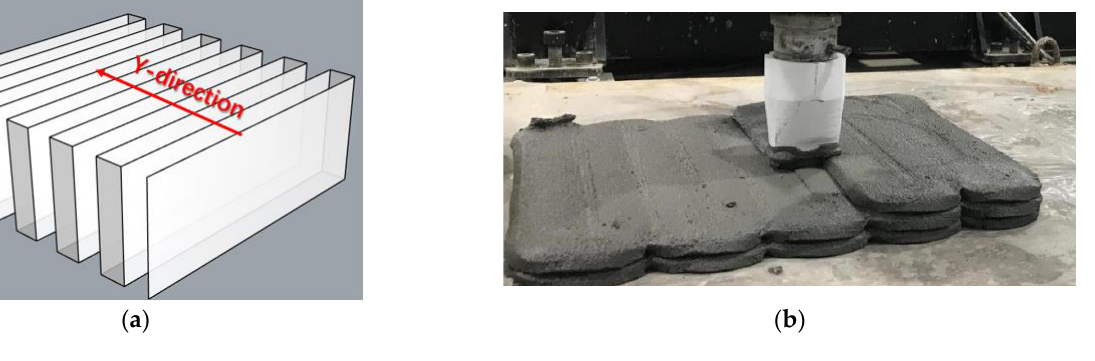
Figure 3. ( a ) Printing path model, ( b ) printing process [60].